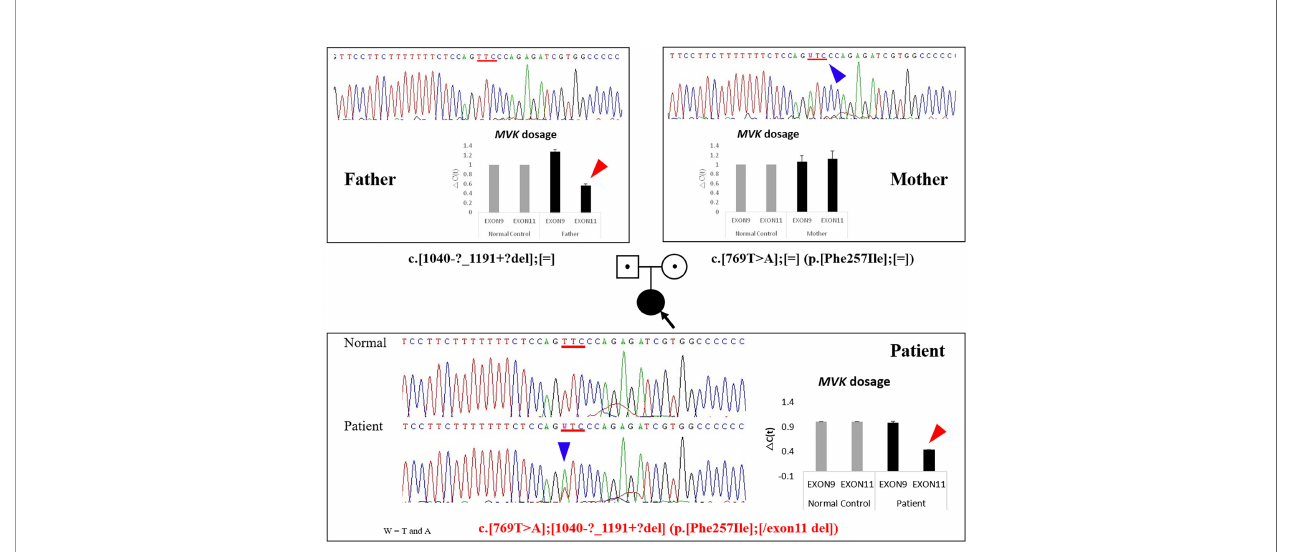
FIGURE 1 | Identi fi cation of mutations by DNA sequencing and relative quanti fi cation of MVK exon 9 and 11 expression in the patient and her parents. The heterozygous MVK mutation c.769T>A (p.Phe257Ile) in the patient was inherited from her mother (blue arrows), and the exon 11 deletion was inherited from her father (red arrows). Fold-change in expression of MVK exons 9 and 11 measured using quantitative RT-PCR. GAPDH expression was used to normalize target gene expression. The relative expression of each gene was calculated as the log2 of 2 - △ Ct values. MVK , mevalonate kinase; RT-PCR, reverse transcription PCR; GAPDH , glyceraldehyde 3-phosphate